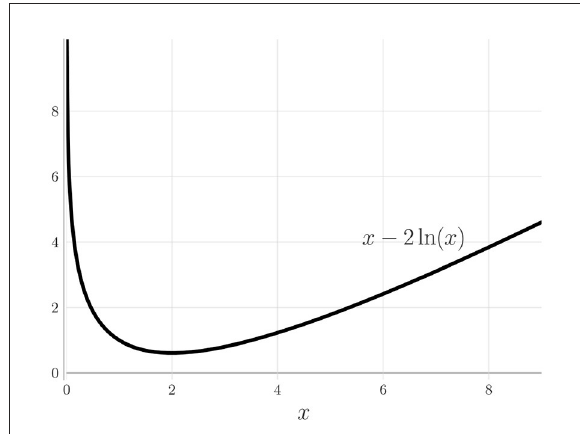
FIGURE2 The curve indicates that x − 2ln( x ) is positive when x is